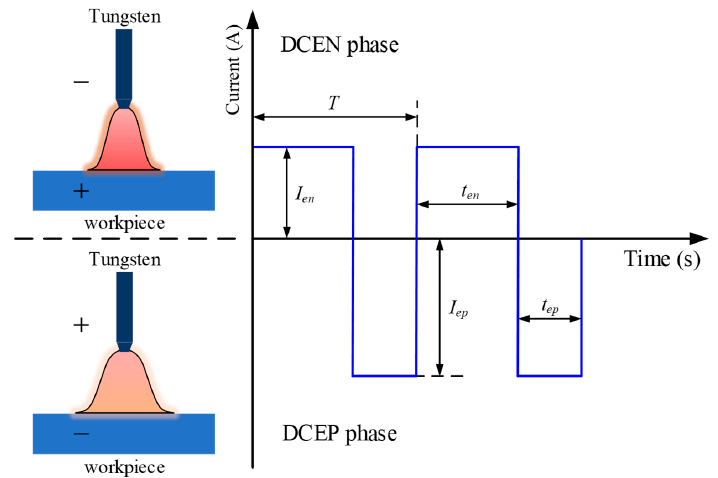
Figure 1. Current waveform of VP-GTAW process.